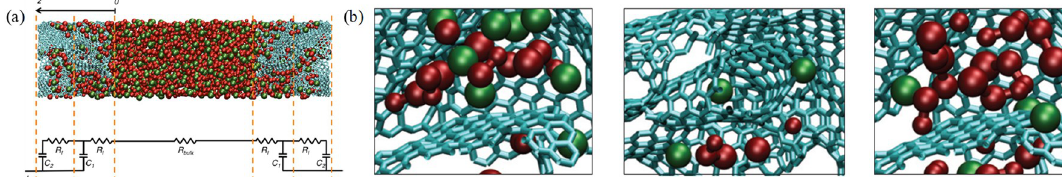
Figure 6. ( a ) Simulation of 1-butyl-3-methylimidazolium hexafluorophosphate (BMI-PF 6 ) ionic liquid electrolyte surrounded by two porous carbon electrodes held at constant electrical potentials (blue: C–C bonds; red: the three sites of BMI + ; green: PF 6- ions) and equivalent electric circuit used to model the simulation setup [103]. ( b ) Typical structure of the ionic liquid inside the electrified pores of the carbon (left: local structure near a positive surface at +0.5 V; middle: a single anion in a nanotube-like pore positively polarized at +0.5 V; right: local structure near a negative surface at − 0.5 V) [104]. ( a ) reproduced from [103], with permission from American Chemical Society, 2014; ( b ) reproduced from [104], with permission from Springer Nature, 2012.